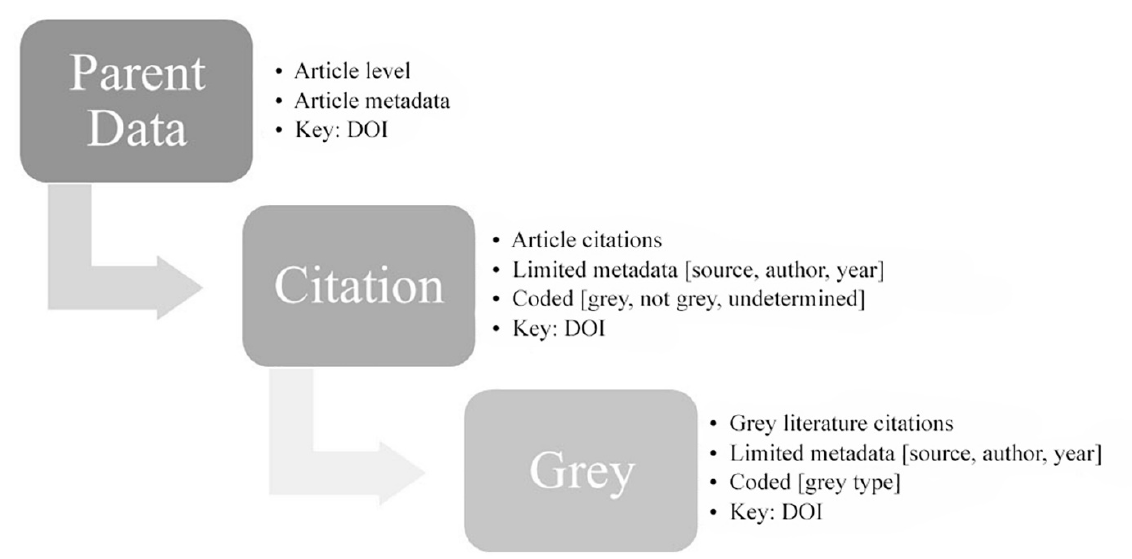
Figure 1 Flowchart of data extraction and coding